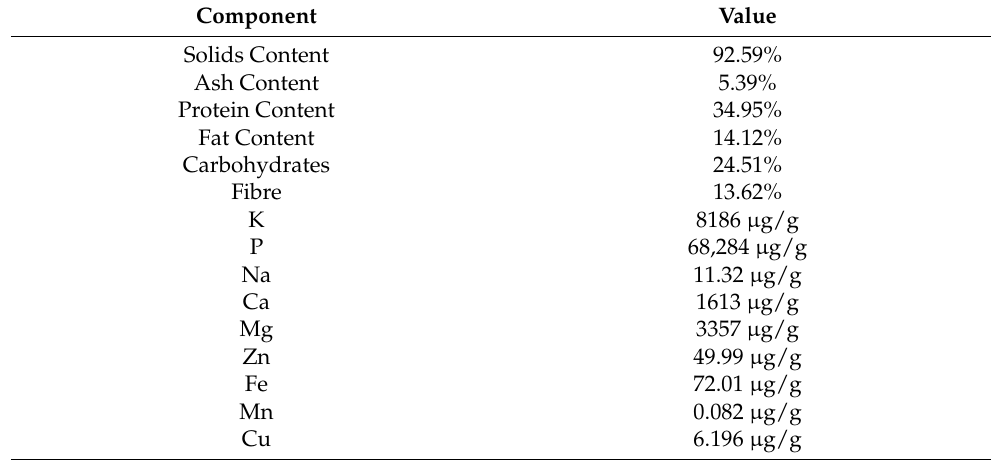
Table 1. The chemical composition of camelina press